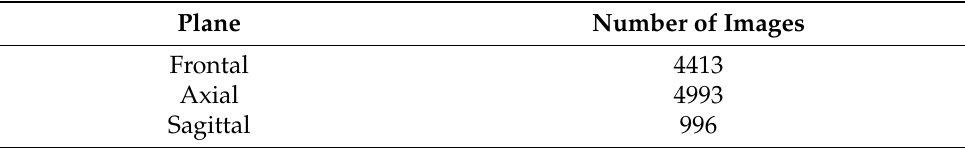
Table 1. Original data set